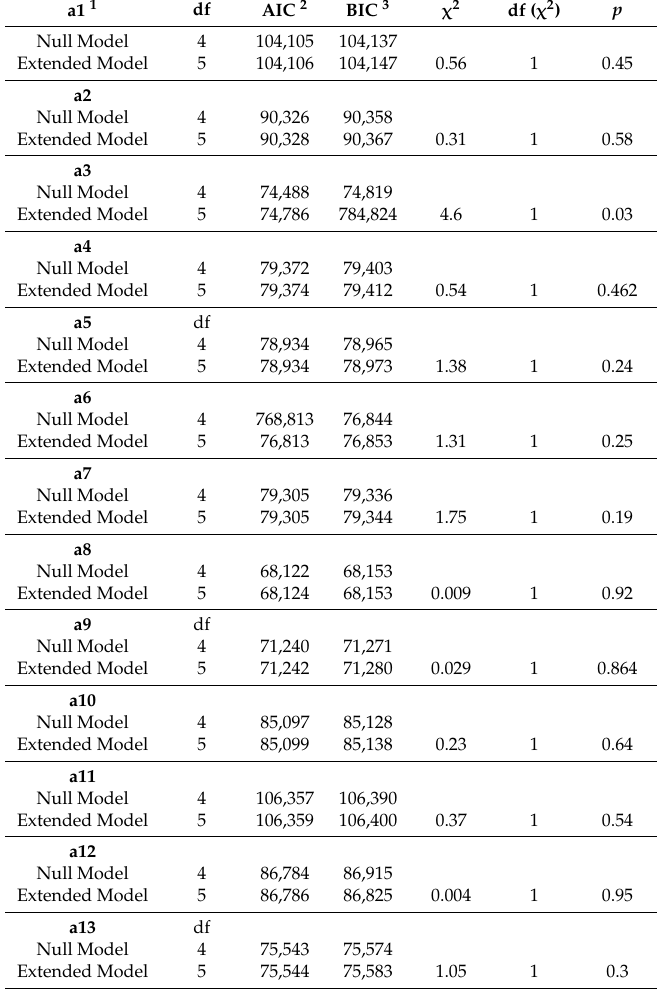
Table A1. Likelihood ratio tests for the null and extended models applied to free parameters in transition matrix A